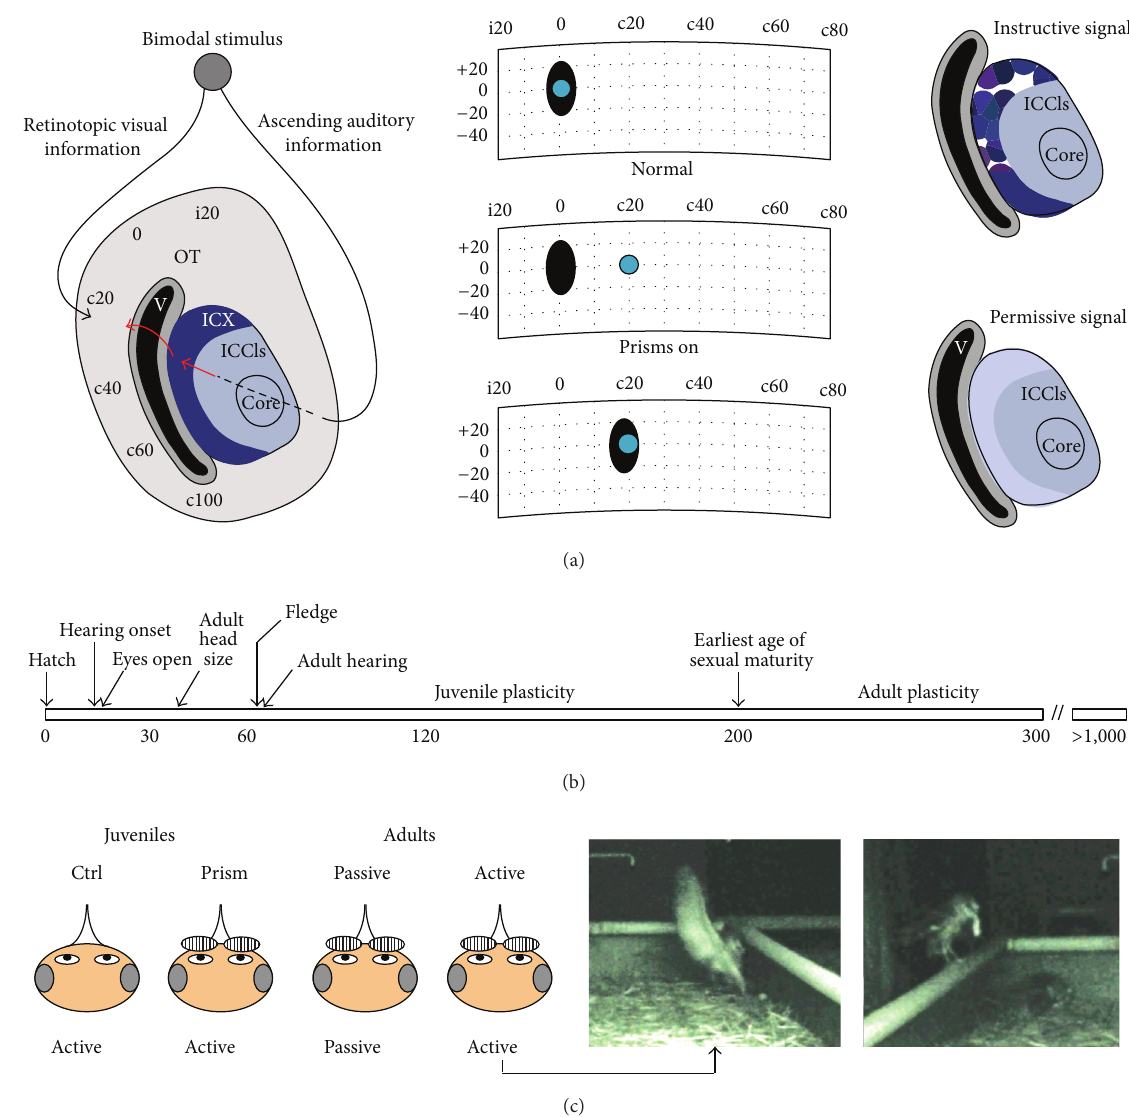
Figure1:Experimentaldesign.(a) Left ,diagramofhorizontalsectionthroughtheLmidbrain.Auditoryinformationascendsthroughthecore to the lateral shell of the central nucleus of the inferior colliculus (ICCls) where neurons tuned to distinct values of interaural time difference (ITD) are arranged topographically to form a map. ICCls neurons project to the external nucleus of the inferior colliculus (ICX) which contains a complete map of auditory space. Major postsynaptic targets in ICX are CaMKII+ space-specific neurons. In turn, these project to the optic tectum (OT) where the auditory map aligns with a visual map derived from retinotopic input: i20 = ipsilateral 20 degrees; c20 = contralateral 20 degrees. In both ICX and OT, ipsilateral space is represented in the rostral pole and contralateral space progressively towards the caudal pole. V = ventricle. Middle , auditory (dark oval) and visual (light circle) spatial receptive fields of a neuron in OT before prism mounting (top), immediately after mounting (middle), and two months later after full adaptation (bottom). The auditory spatial receptive field has reorganized to align with the optically displaced visual field. The primary site of plasticity is the ICX. Right , hallmarks of instructive or permissive signals acting at the cellular level within ICX. Instructive signals are expected to produce bimodal effects distributed in patches across rostral ICX, depicted here as multicolor islands. Because prisms do not displace the peripheral visual field, no signal is expected in caudal ICX. In contrast, permissive signals are expected to act across the entire rostrocaudal extent, and with uniform effects at the cellular level, depicted here as constant shading. (b) Developmental timeline of physical features [28, 29] and hearing onset and maturation [30]. Plasticity in juveniles occurs readily with passive feeding on dead mice. After sexual maturity, plasticity in adults requires either active hunting or incremental training. (c) Four experimental groups used in this study: Ctrl (juveniles, no prisms, and active feeding), prism (juveniles, with prisms, and active feeding), passive (adults, with prisms, and passive feeding), and active (adults, with prisms, and active feeding). An example of successful hunting episode recorded with infrared videography is shown on the far